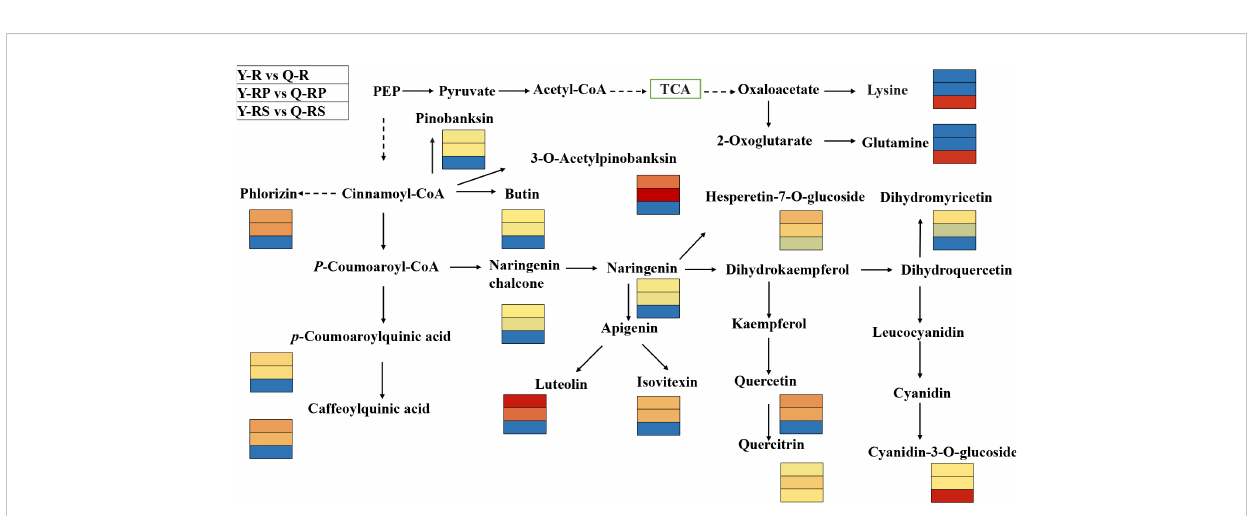
FIGURE 8 Overview of the probable regulation of some key metabolites mapped to metabolic pathways in pairwise comparisons of the raspberry from different plateaus. The red color small rectangle indicates that the metabolite content is signi fi cantly up-regulated; the blue rectangle indicates that the metabolite content is signi fi cantly